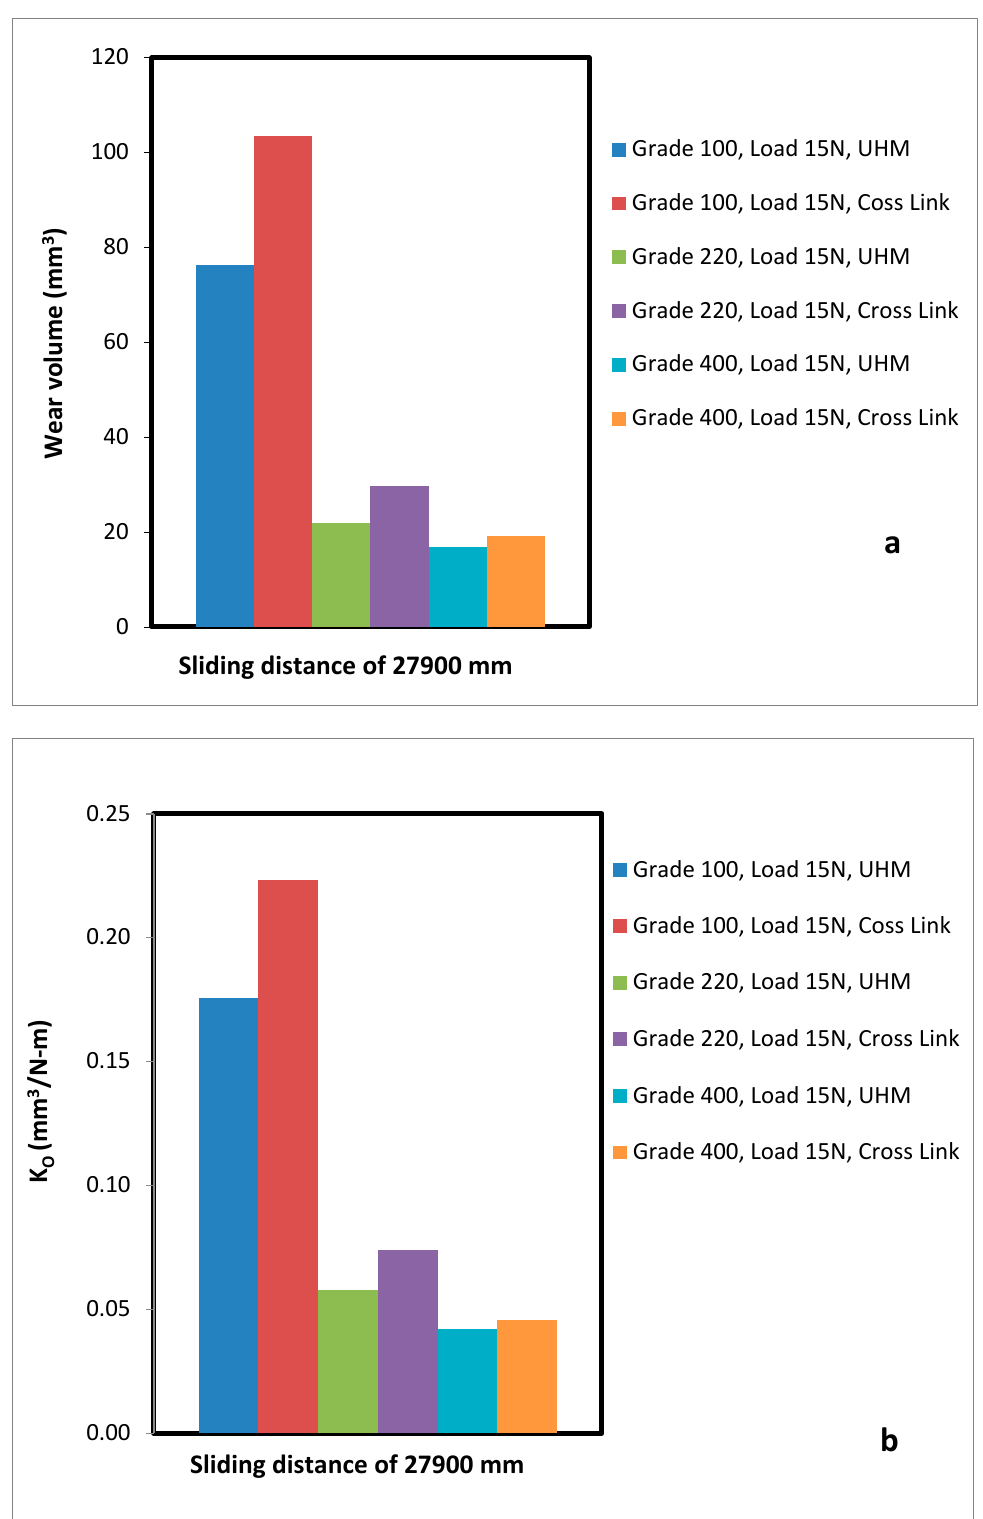
Figure 6. Full Comparison of UHMWPE and Cross-link PE ( a ) wear volume at all wear condition with load 10 N ( b ) Specific wear rate at all wear conditions with load 15 N.